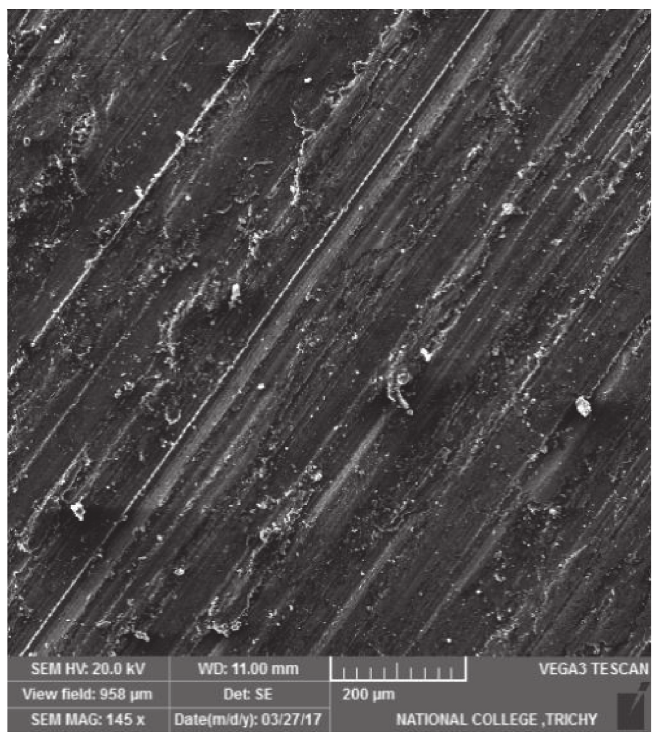
Figure 12: SEM image of Al7075 85% and TiB